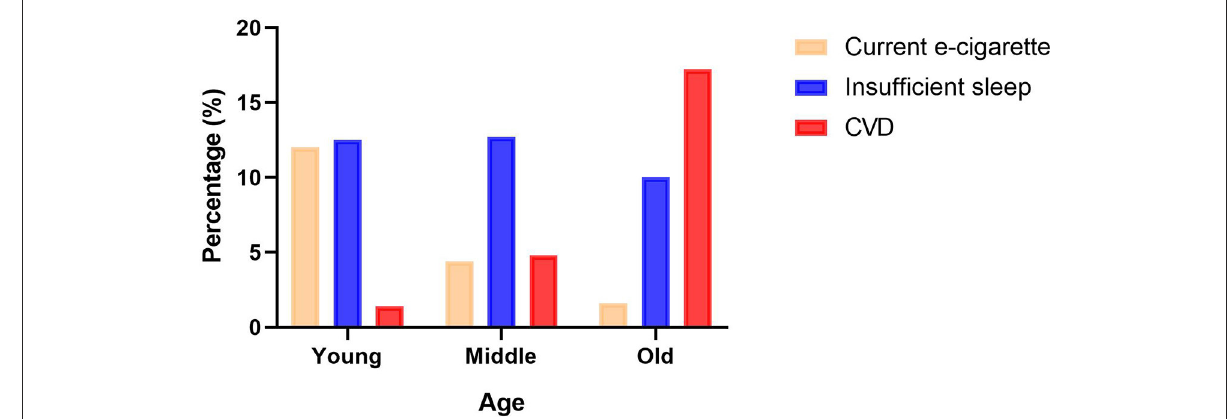
FIGURE1 The prevalence of current electronic cigarettes, insufficient sleep duration, and cardiovascular disease (CVD) in young, middle, and old adults. The orange column represents the prevalence of current electronic cigarettes; the blue column shows the prevalence of insufficient sleep duration; the red column indicates the prevalence of CVD.